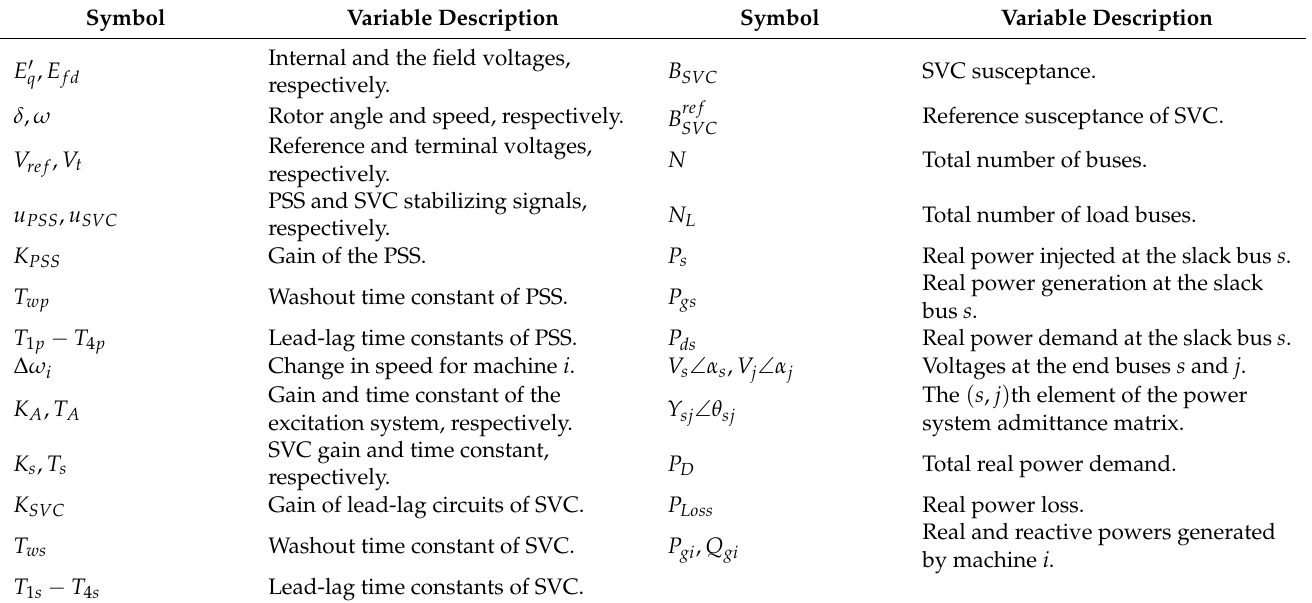
Figure 5. Power system equipped with PSSs and SVC controllers. Table 2. List of